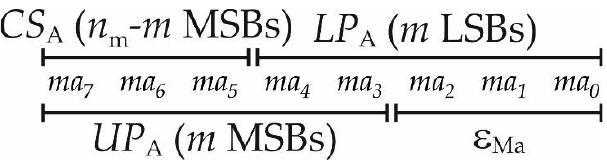
Figure 4. Segmentation of the mantissa Ma in the case n m = 8 bits and m = 5 bits. Please note that an approximation error is introduced when the upper portion of the mantissa is multiplied (i.e., when the selection flag is high) since the less significant part is discarded (namely ε Ma in the figure). On the contrary, no approximation is introduced if the lower portion is selected.